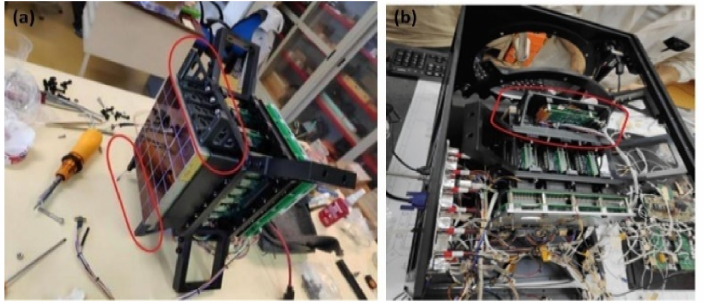
Figure 6. The Mini-EUSO used in the International Space Station: ( a ) 3D printed Ultem 9085 brackets (in red), and ( b ) The final unit with electronics